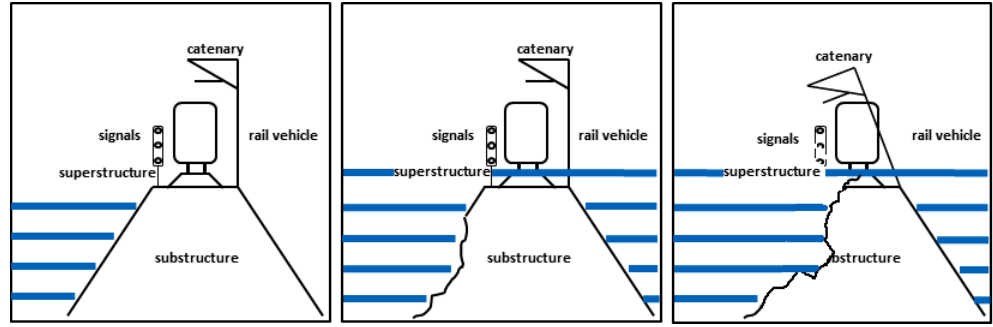
Figure 1. Damage classification scheme (adapted from Moran et al.,